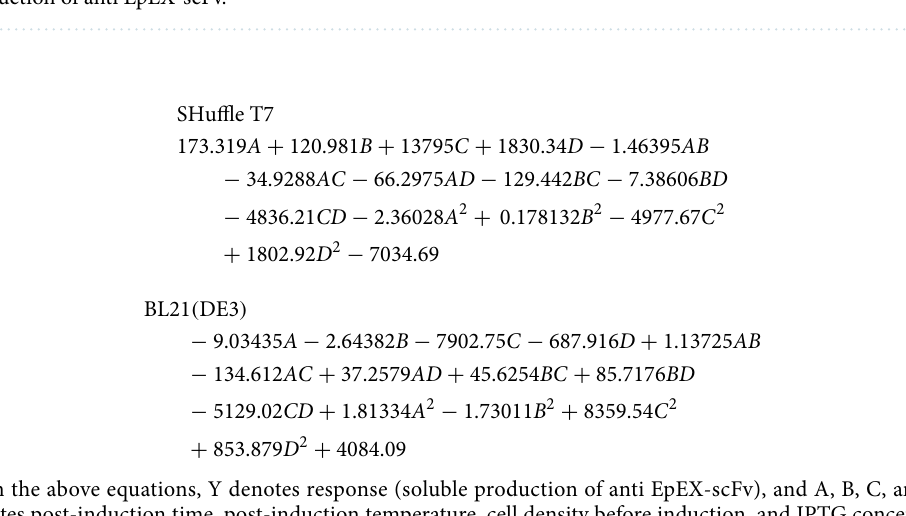
Table 2. Analysis of variance for the experimental results of the central-composite design for soluble production of anti